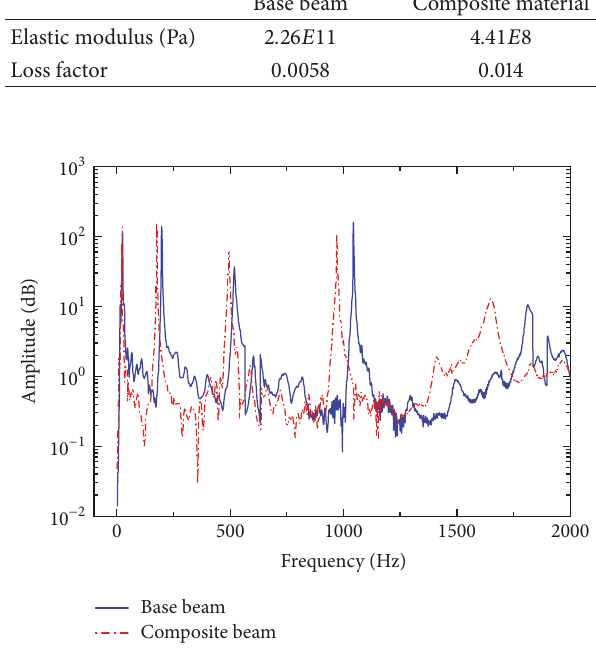
Figure 5: Experimental acceleration amplitude.